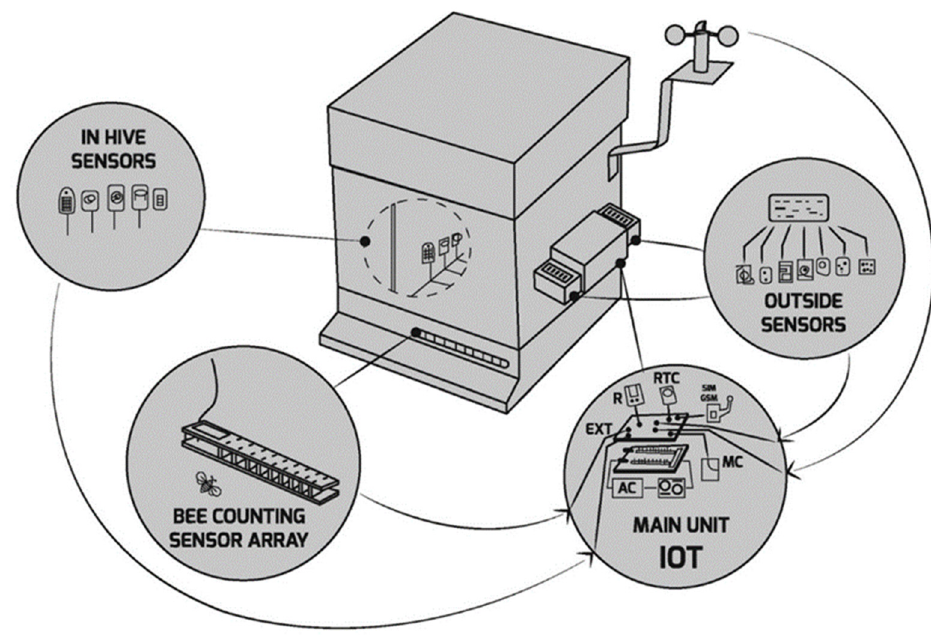
Figure 3. Schematic of data collection system.